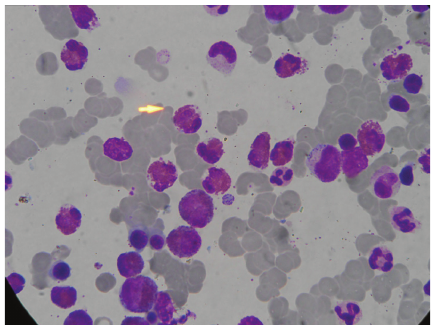
Figure 2: Bone marrow picture showing markedly increased num- ber of eosinophils. (Leishman stain ×